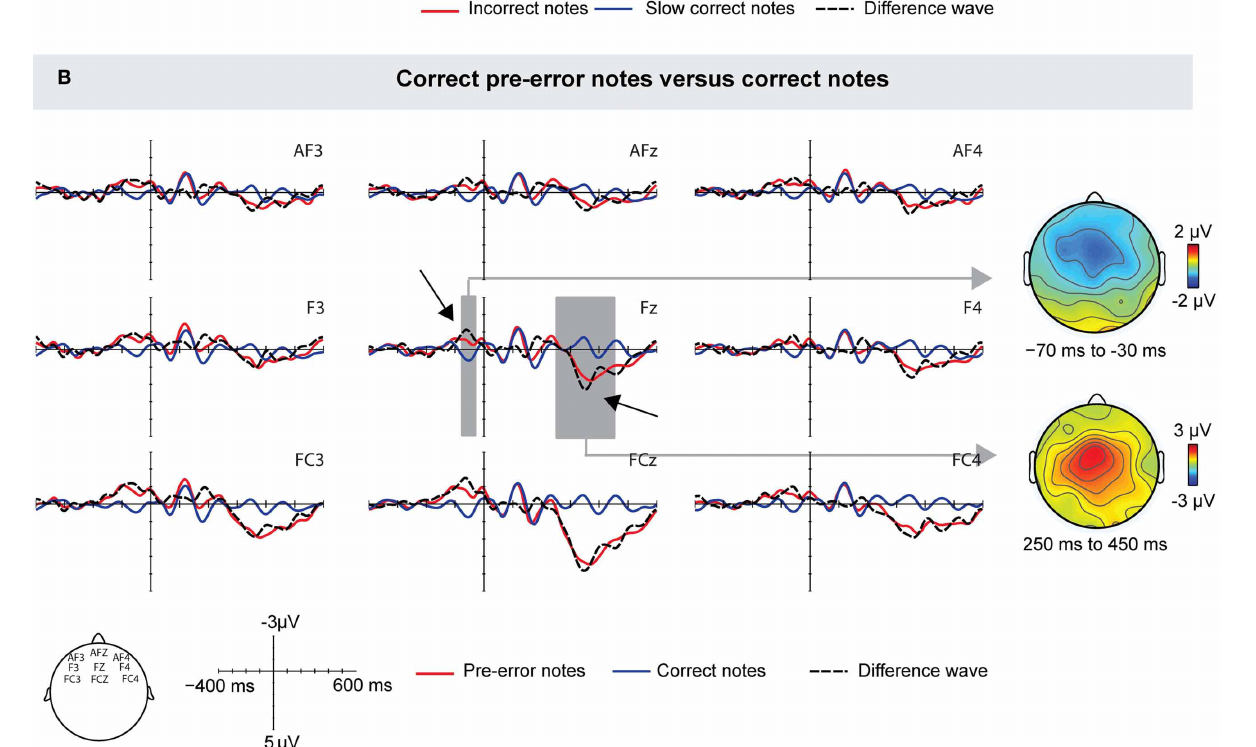
FIGURE 4 | Grand-averaged ERPs (left) and scalp topographies (right) based on the MIDI data. (A) Compared to correct (but slow) keystrokes, incorrect keystrokes elicited a similar (marginally significant) negativity peaking around 50ms prior to MIDI onset, followed by a Pe around 220ms after MIDI onset. (B) Compared to other correct keystrokes, the correct keystrokes immediately preceding incorrect